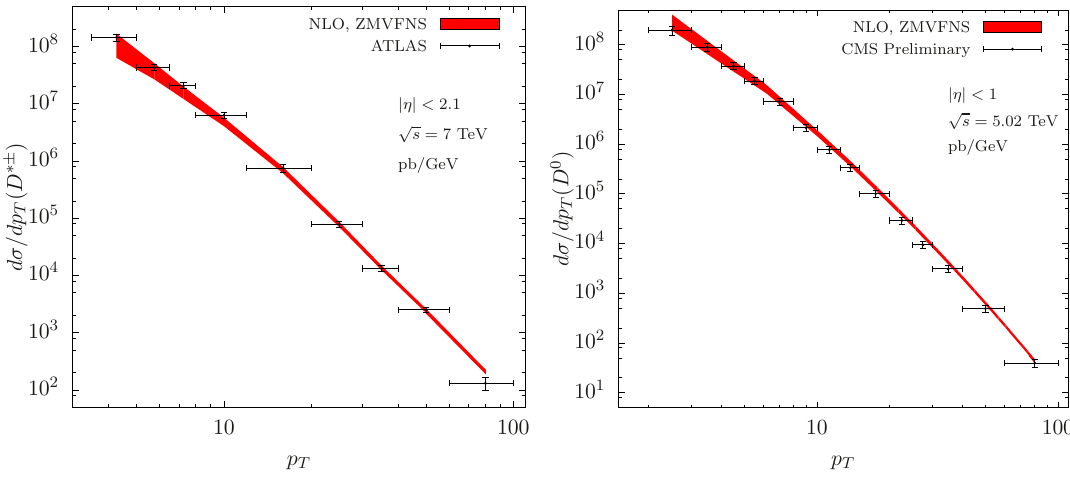
p s = 7 TeV (left) and for pp ! D 0 X